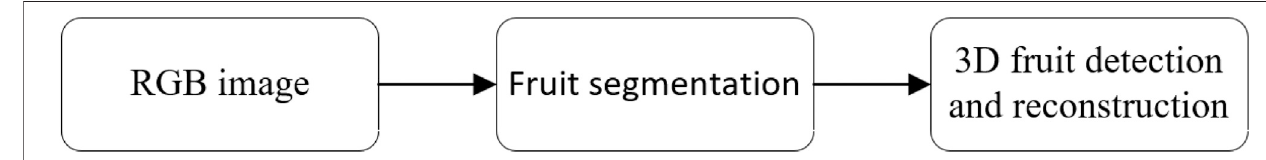
FIGURE 2 | Fruit detection algorithm fl ow diagram. Step (1): image preprocessing and dataset annotation; Step (2): fruit segmentation on the Mask R-CNN; Step (3): point cloud acquisition and